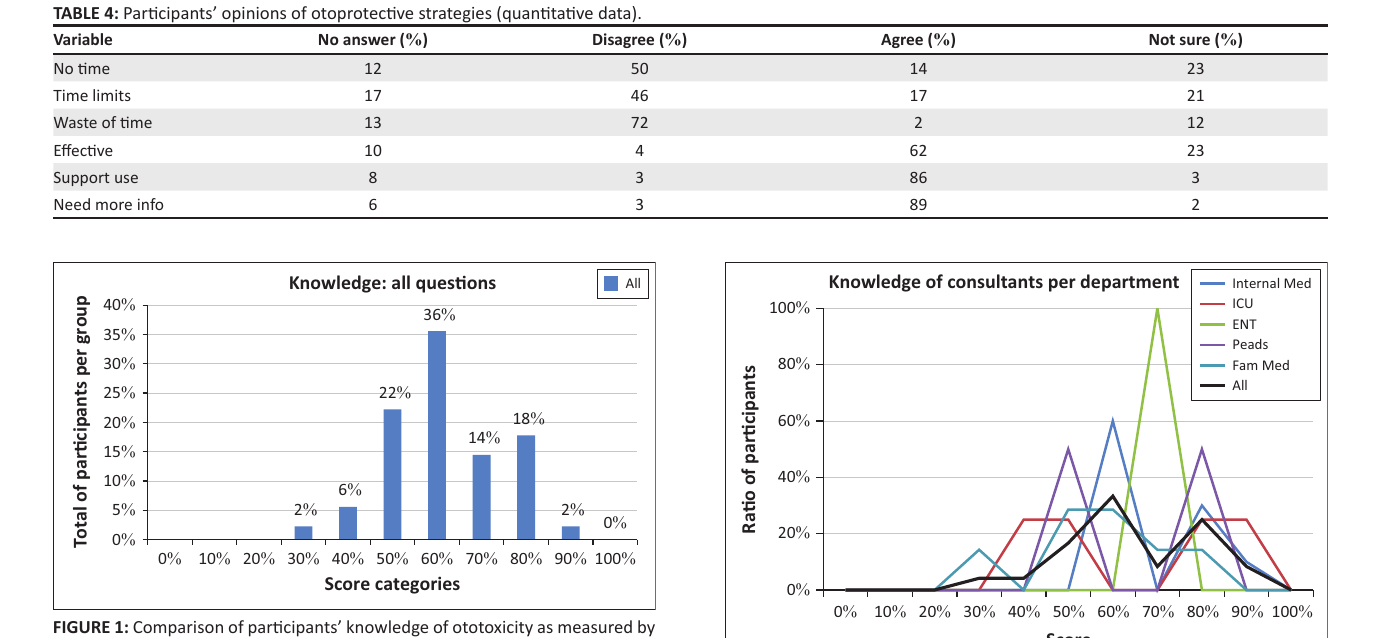
FIGURE 1: Comparison of participants’ knowledge of ototoxicity as measured by all questions (for the entire group of participants).